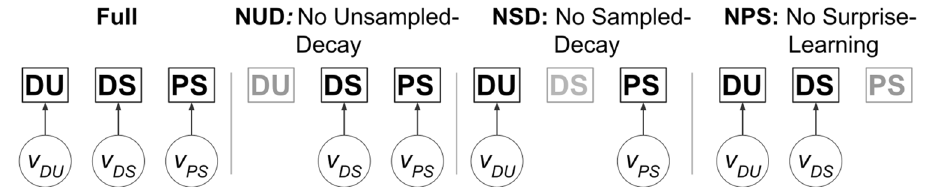
Figure 2. Graphic summary of learning models. Four variants of the learning model are compared, differentiated by their forgetting kinetics with associated prior volatility parameters ν . The NUD and NSD models omit decay of concentration parameters of beliefs for unsampled and sampled actions respectively (corresponding to ν UD = 0 and ν SD = 0 ), while the NPS model excludes surprise-based learning ( ν PS = 0 ). The more complex Full model incorporates all three learning